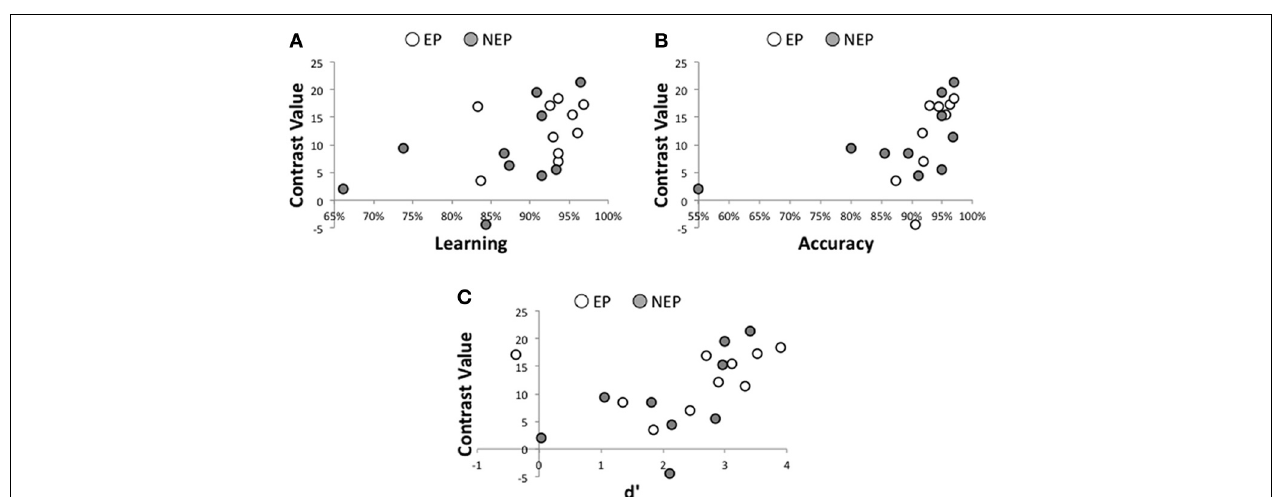
FIGURE 5 | Brain-Behavior Relationships. For all participants, learning (measured prior to entering the scanner) is significantly related to recruitment of the left IFG while processing the newly learned language (A) , as is accuracy (percent correct; B ) and discrimination sensitivity (d’ ,C ).